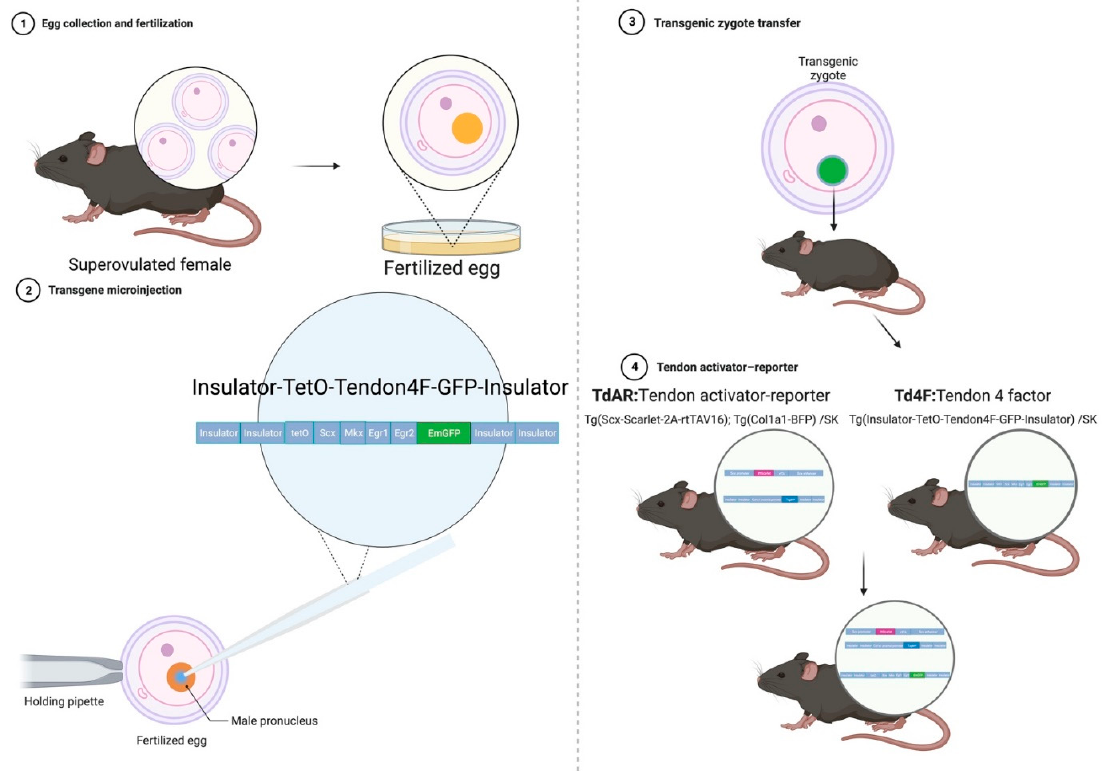
Figure 1. Scheme of TdAR-Td4F transgenic mouse generation. The constructed recombinant plasmids containing Insulator-TetO-Tendon4F-GFP-Insulator were linearised and purified. Then, Tg(Insulator- TetO-Tendon4F-GFP-Insulator)/SK for the tendon 4-factor transgenic mouse (Td4F) mouse line was obtained with a pronuclear microinjection [24]. Tg(Scx-Scarlet-2A-rtTAV16) Tg(Col1a1-BFP)/SK